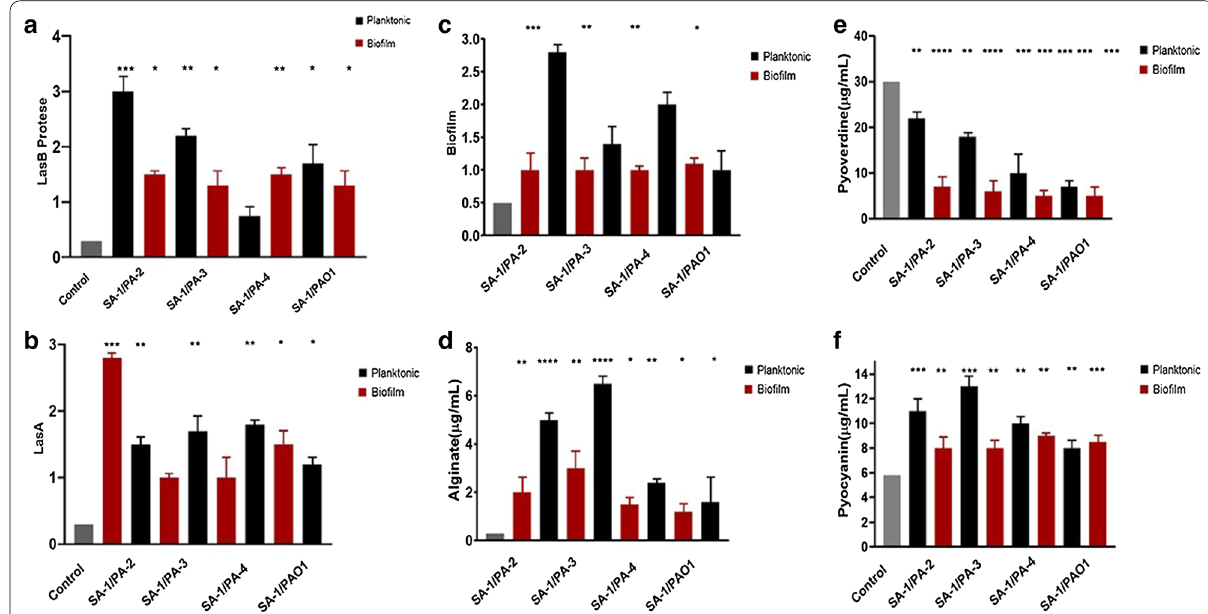
Fig. 4 The changes in virulence factor production in P.aeruginosa strains. LasB protease ( a ), LasA protease ( b ), biofilm formation of P. aeruginosa ( c ), alginate production ( d ), pyoverdine ( e ), and pyocyanin ( f ) were investigated. ’ *: p < 0.05, **: p < 0.001, ***: p < 0.0001. No stars: the non-statistical